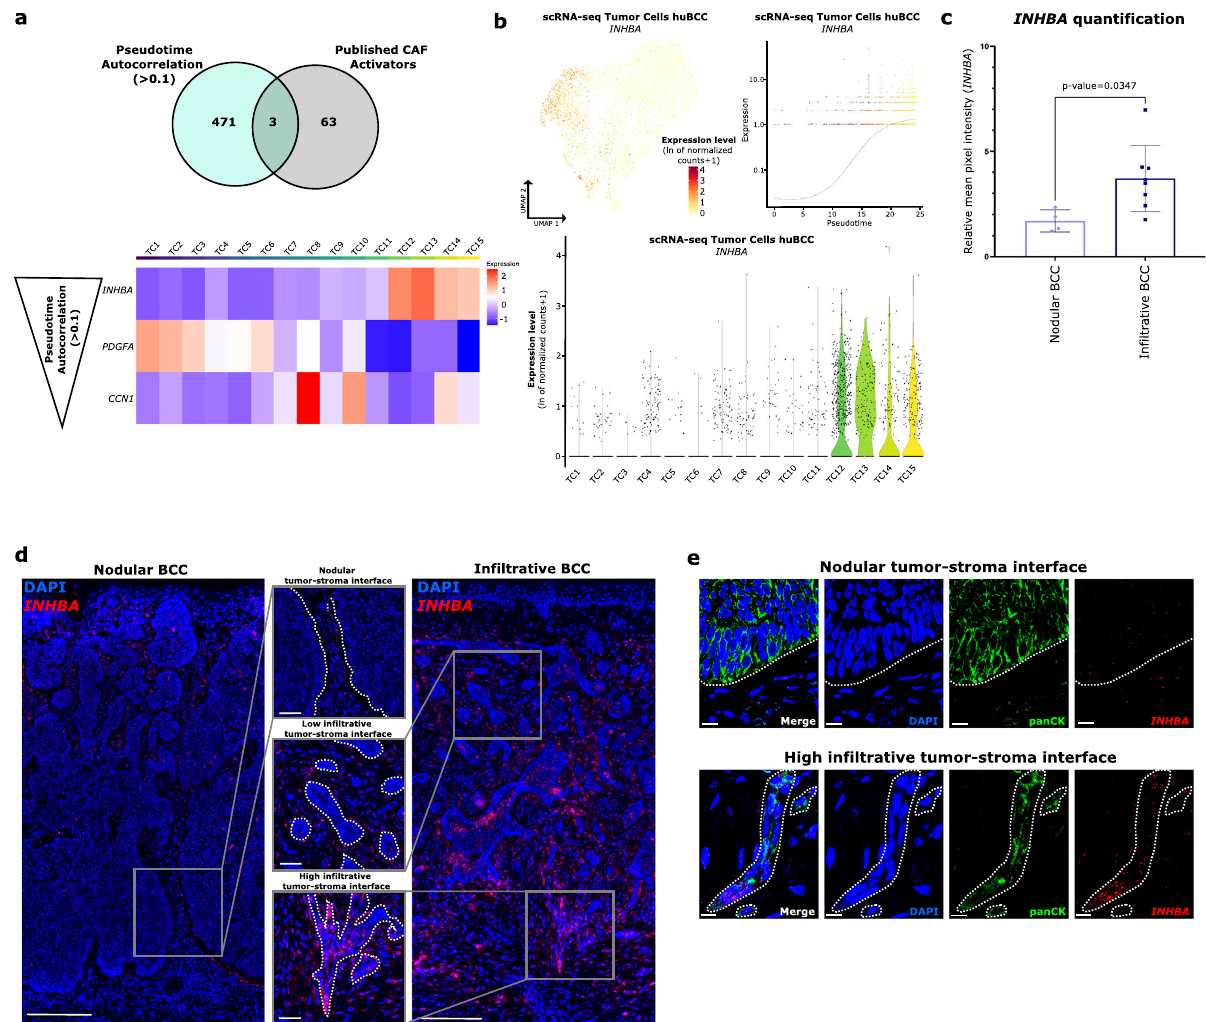
Fig. 6 | INHBA is preferentially expressed in the highly in fi ltrative tumor tips. a Venn diagram showing the overlap between genes with a positive (>0.1) pseu- dotime autocorrelation index and known CAF activators (upper panel). Lower panel shows the average expression level per ranked cluster of the three over- lapping genes, ordered by decreasing autocorrelation index, in tumor cell sub- populations of the scRNA-seq dataset. b Expression level of INHBA in the tumor cell subpopulations of the scRNA-seq dataset, represented as a color scale overlaidontheUMAPplot(upperleftpanel)andasviolinplotsperrankedcluster (lower panel). Expression level per cell of INHBA along the pseudotemporal tra- jectory of tumor cell subpopulations (upper right panel). c Bar graph repre- senting the relative intensity of INHBA expression in tumor cells located at the tumor-stroma interface of nodular ( N =4) and in fi ltrative ( N =8) BCC samples (measured in n ≥ 15 regions/sample). Horizontal bars indicate the mean±SD.